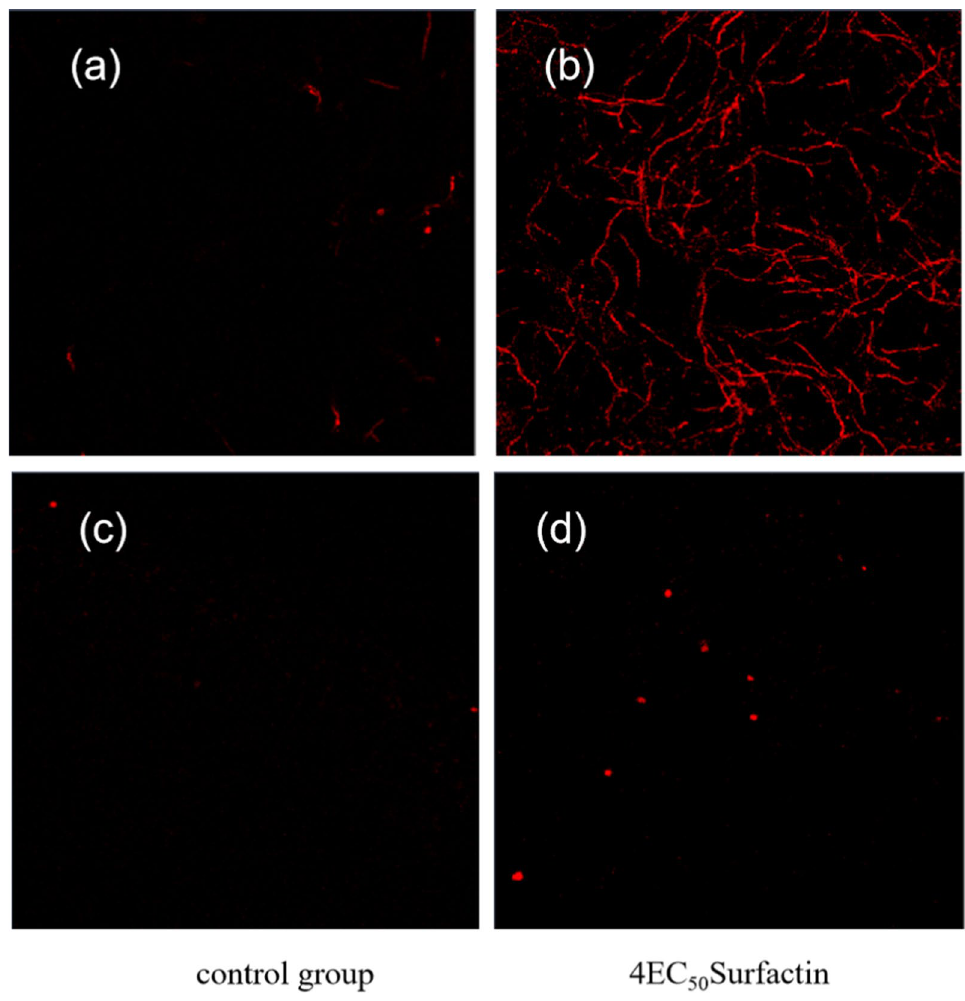
Fig. 6 Different levels of propidium iodide staining of mycelia ( a , b ) and spores ( c , d ) of B. cinerea in the control and 4 EC 50 surfactin groups. Images were obtained by laser scanning confocal microscopy at 10 ×